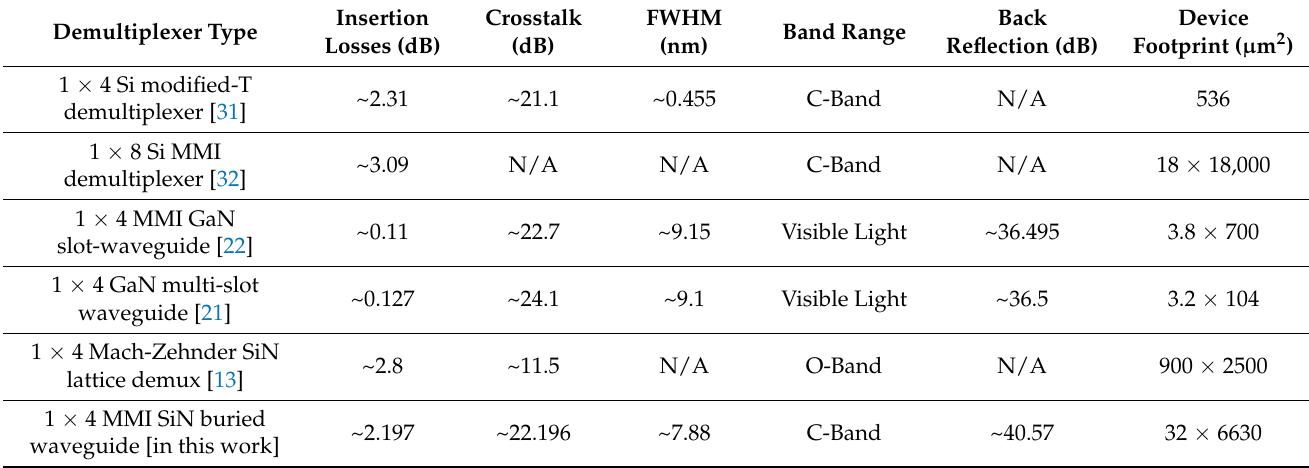
Table 4. Characteristics comparison between various demultiplexer